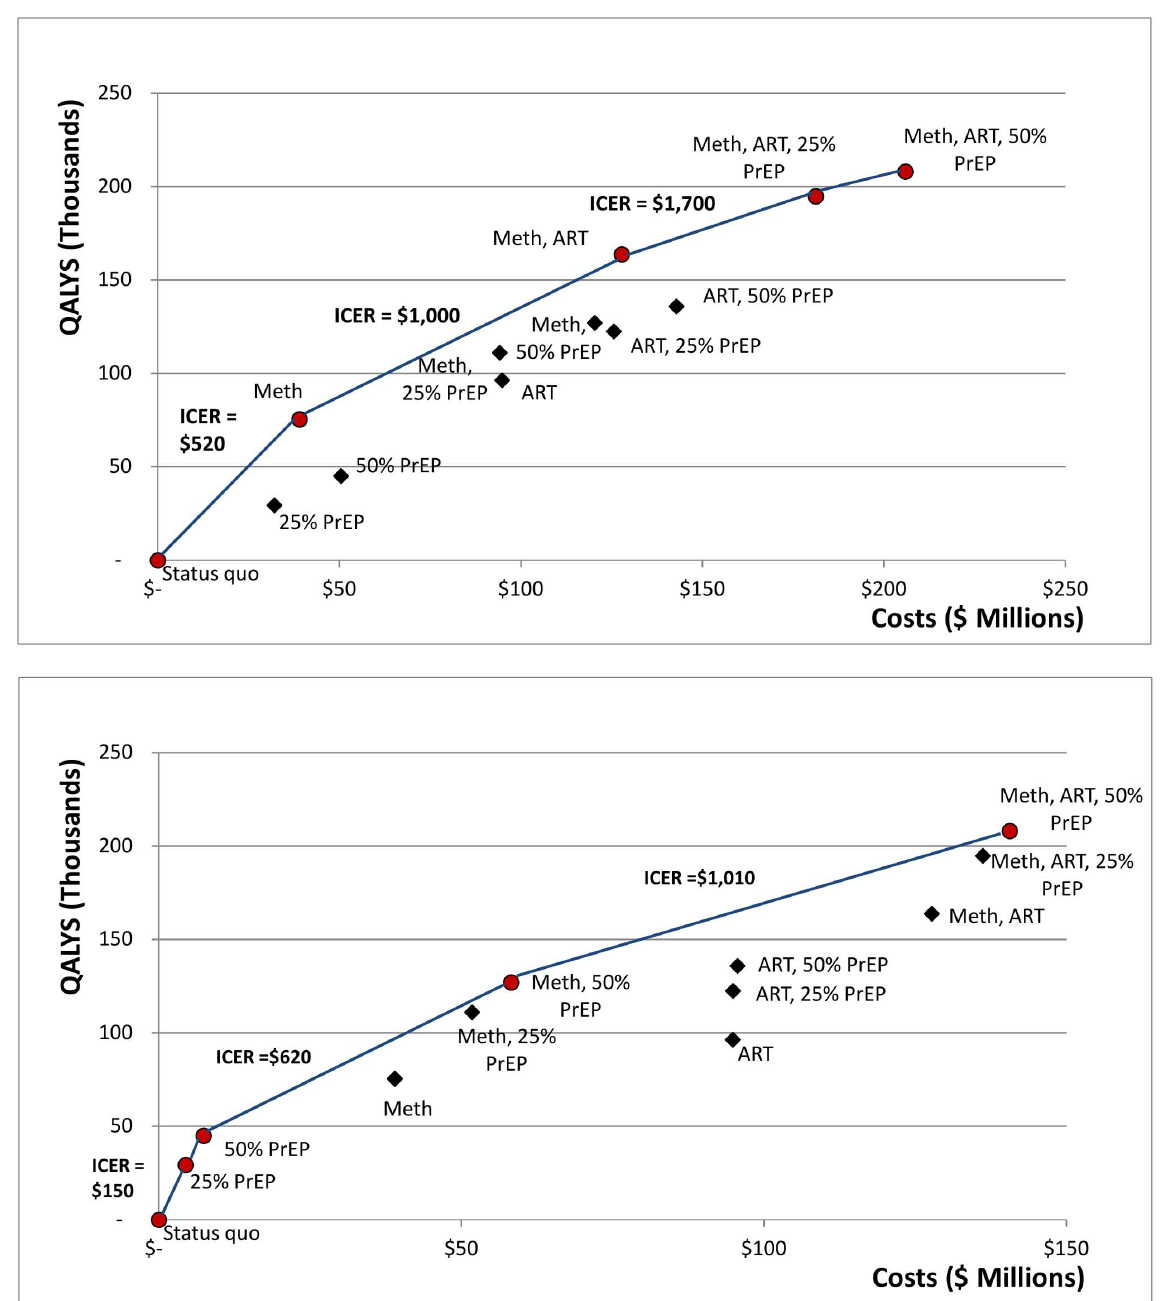
Figure 3. Cost effectiveness of alternative prevention and treatment strategies. Assumes annual PrEP cost of $ 950 (Figure 3a) and $ 450 (Figure 3b). PrEP=oral pre-exposure prophylaxis for injection drug users; ART=antiretroviral therapy for 80% of eligible individuals; MMT=methadone maintenance treatment for 25% of IDUs; 25% PrEP=PrEP for 25% of uninfected IDUs; 50% PrEP=PrEP for 50% of uninfected IDUs.